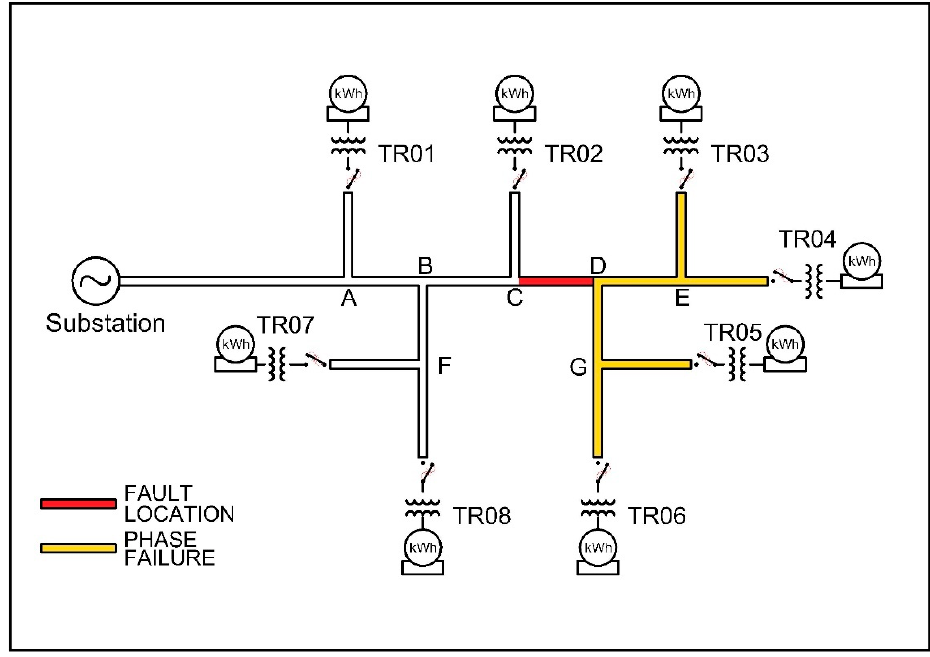
Figure 8. Faults on section CD.